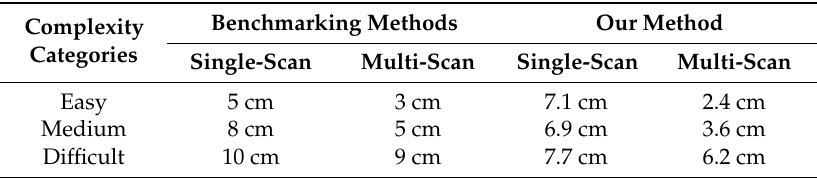
Table 5. Comparison of the maximum RMSE of stem location between TLS benchmarking methods and our